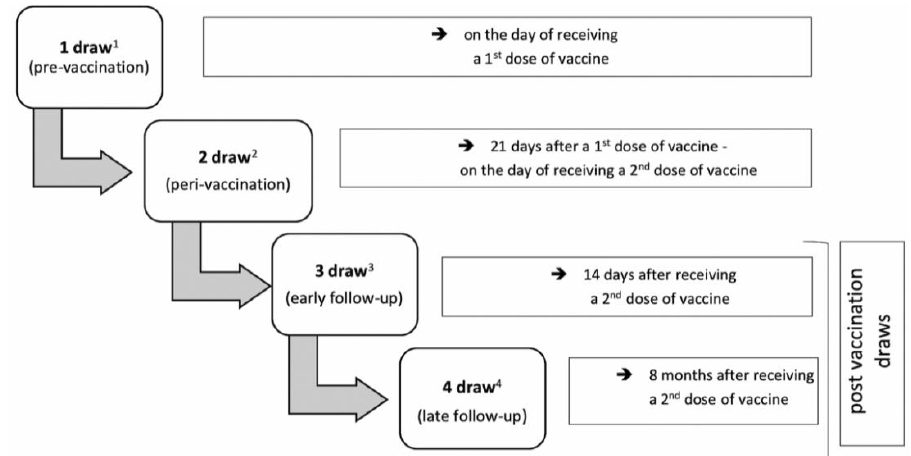
Figure 2. Schematic diagram of the sample collections. 1 — draw before starting the vaccination (on the day of receiving the first dose of the vaccine); 2 — draw on the day of receiving the second dose of the vaccine (21 days after receiving the first dose); 3 — draw 14 days after receiving the second dose of the vaccine; 4 — draw 8 months after receiving the second dose of the vaccine. The first two blood draws were performed prior to administering the vaccine.